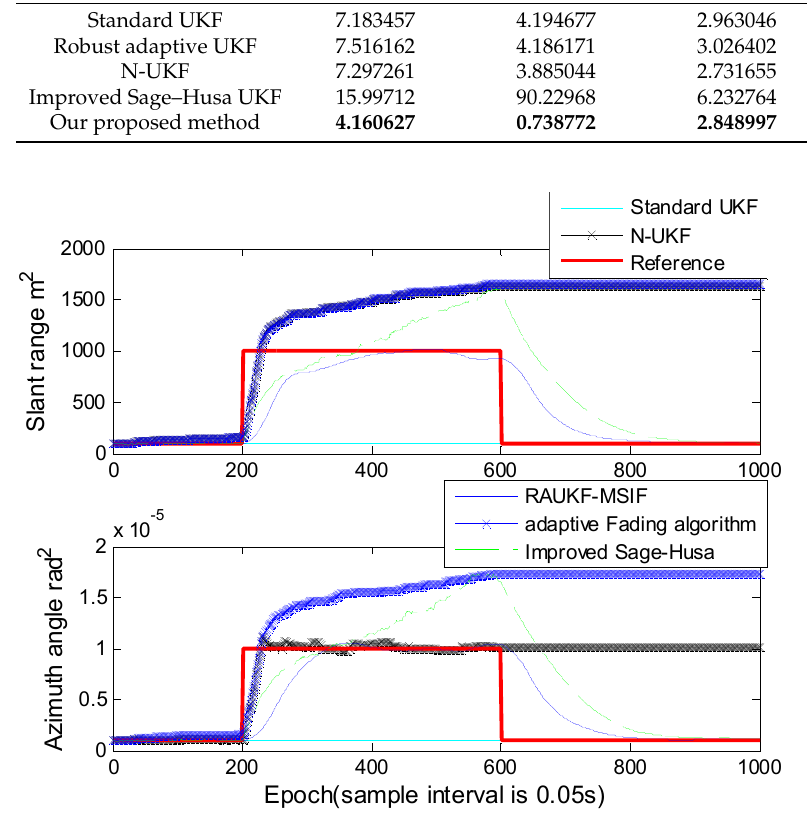
Figure 6. Estimated measurement noise by the algorithms in Case 2.